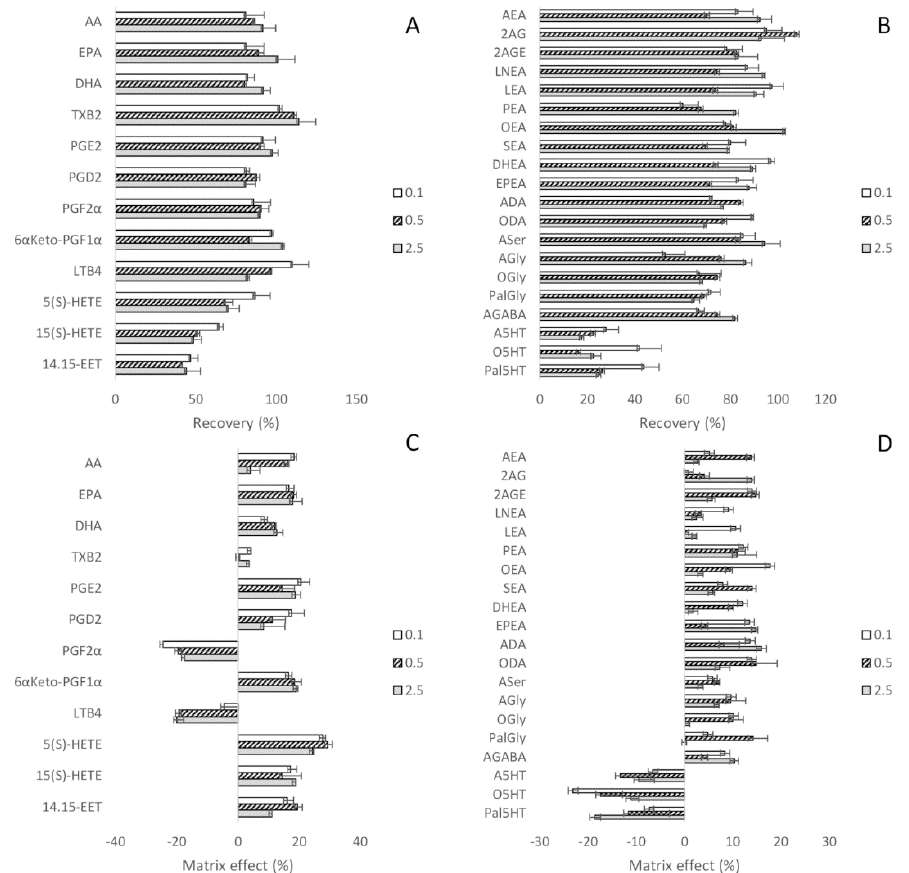
Figure 4. Extraction recovery and matrix effect of PUFAs/eicosanoids ( A , C , respectively) and ECs/NAEs ( B , D , respectively).